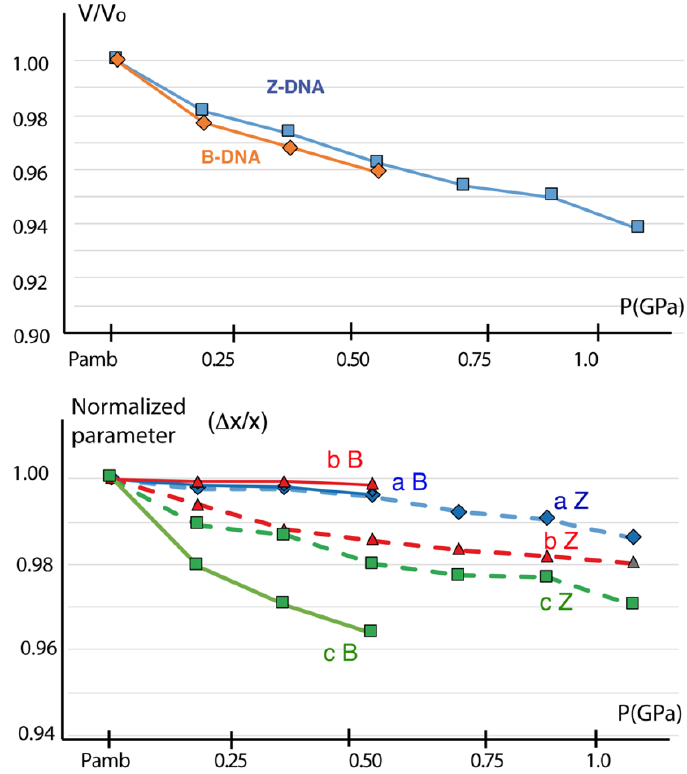
Figure 4. Top : Volume compressibility V(P) normalized as V/Vo for the B-dodecamer (in orange) and the Z-hexamer (in blue). In both cases, a rapid decrease is first observed at P ≤ 250 MPa, followed by a linear dependency. Bottom : Evolution of the corresponding normalized cell parameters showing the anisotropy of the compression. The a unit-cell parameter is in blue, b in red, and c in green. Solid lines for the B-DNA, dotted lines for the Z-DNA.